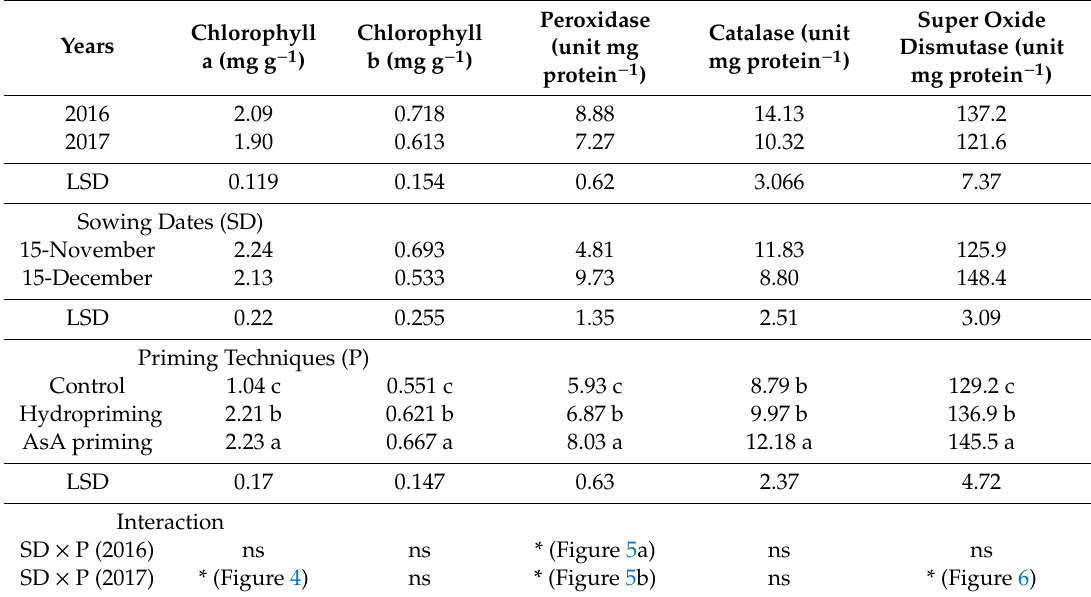
Table 2. Mean comparison of the e ff ect of seed priming and sowing dates on biochemical traits of